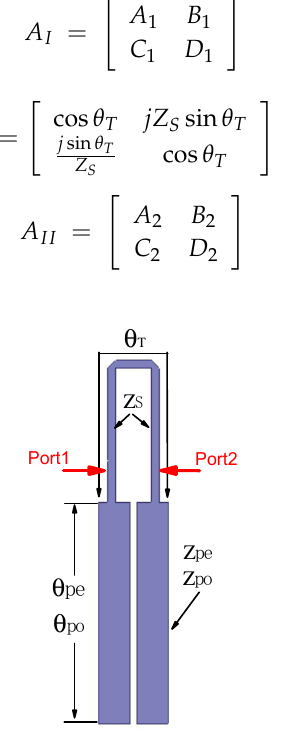
Figure 4. SIR hairpin with internal coupling.